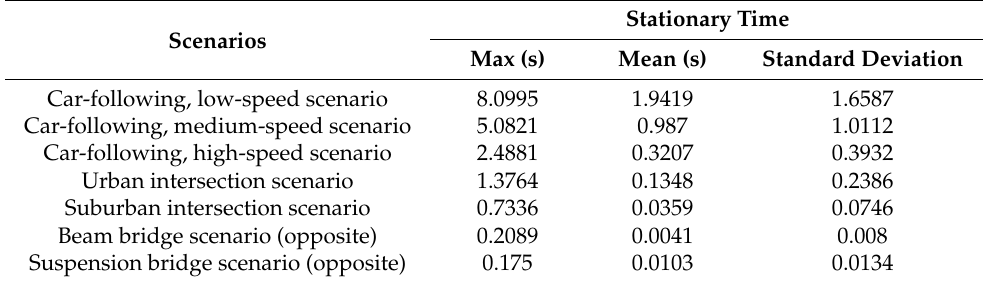
Table 1. Stationary times for the seven scenarios.